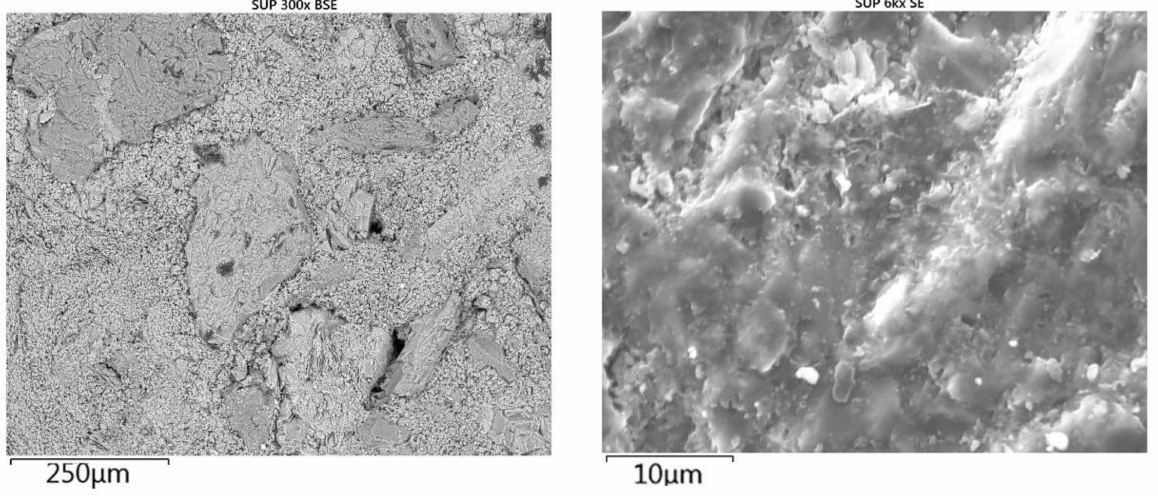
Figure 11. SEM-EDS images: Morphology of the sample surface after application of product NSW (University of Bari Aldo